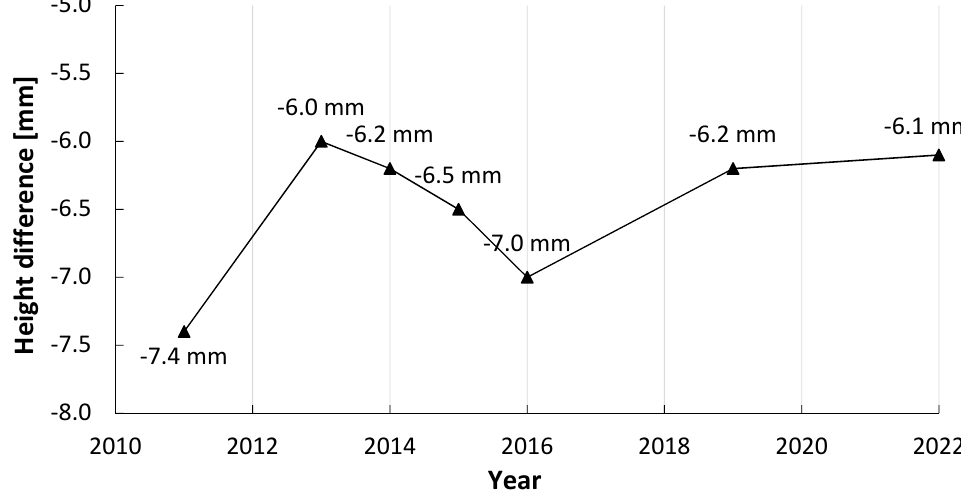
Figure 9. Height difference between KRA1 and KRAW from the levelling from 2011 to 2022.